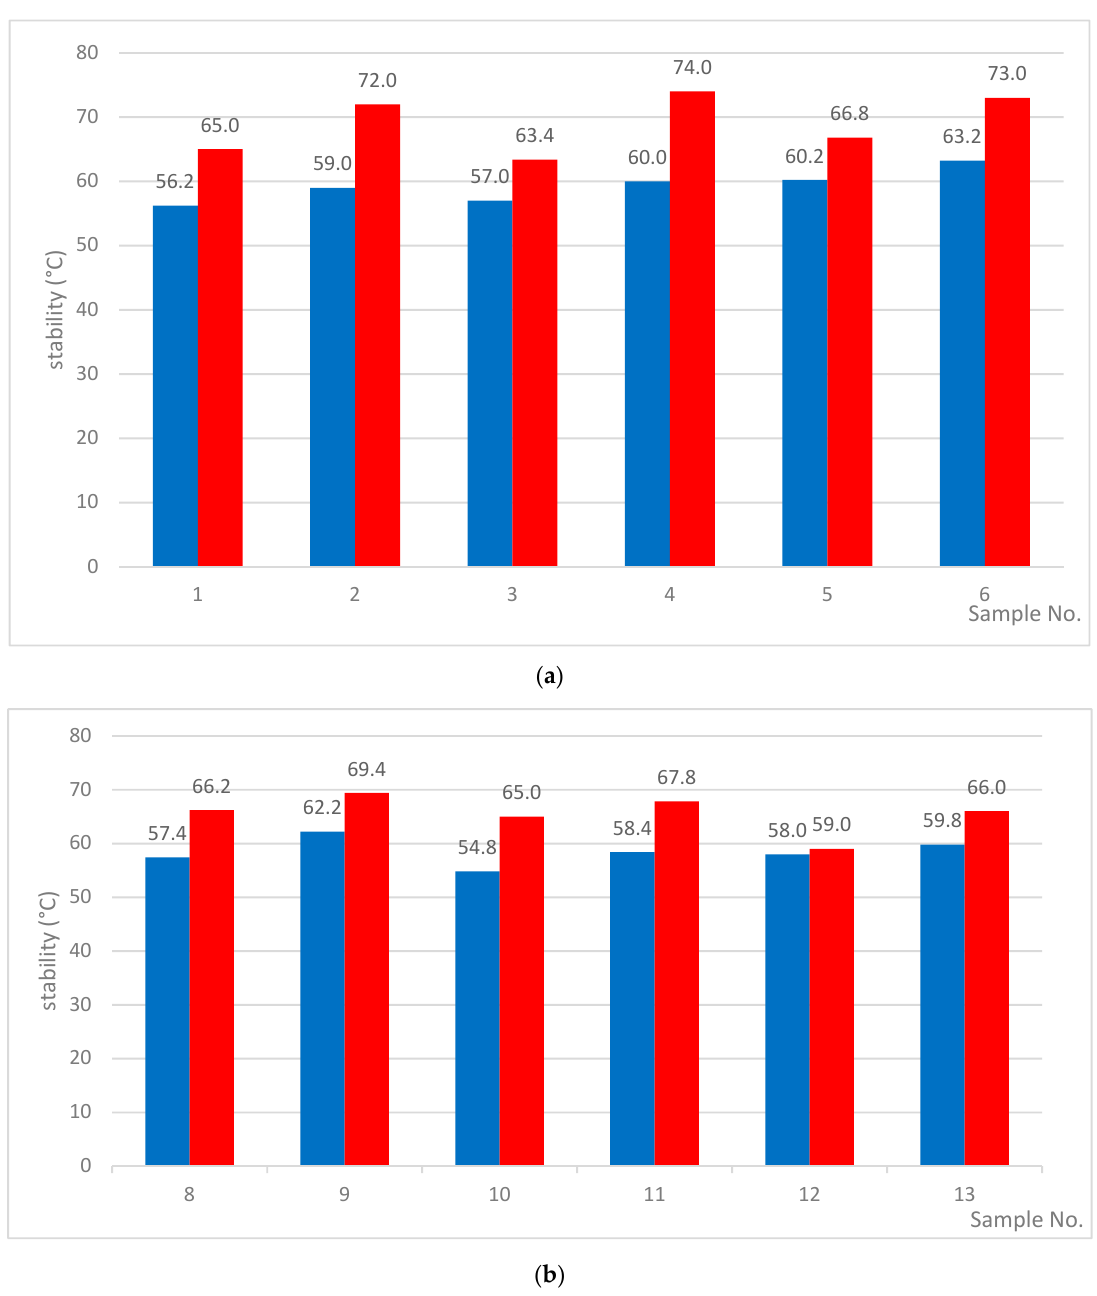
Figure 4. Relations between R&B top/R&B bottom for the bitumens modified at: ( a ) 190 °C and ( b ) 220 °C.